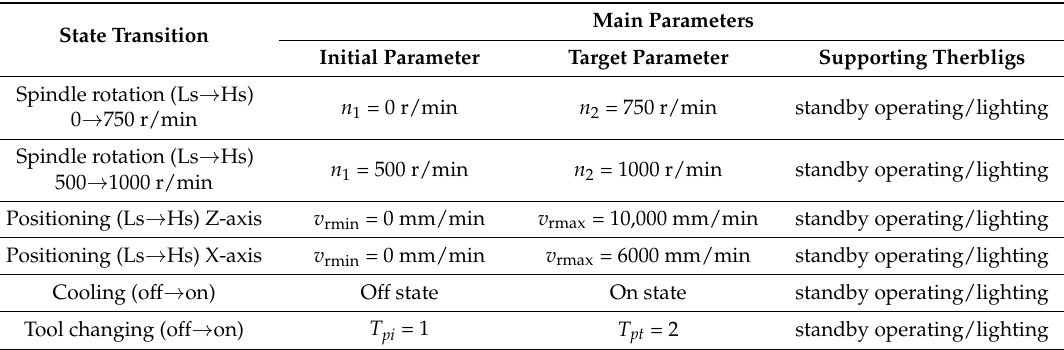
Table 1. Main parameters of state transition cases.